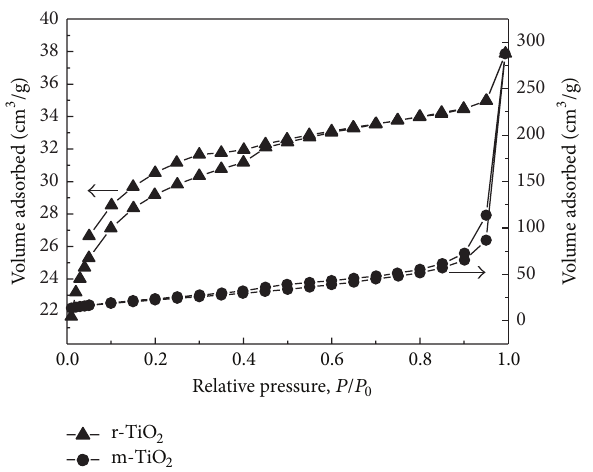
Figure 4: Nitrogen adsorption-desorption isotherms of the r-TiO 2 and m-TiO 2 after calcination at 500 ∘ C for 2 h.